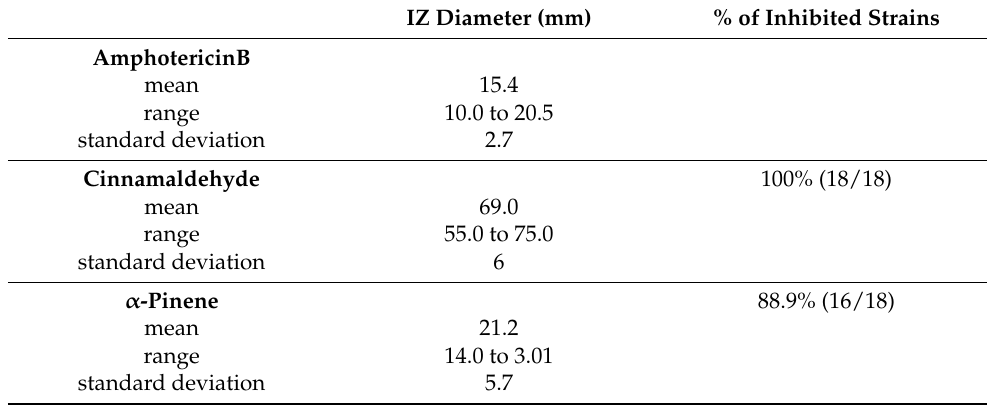
Table 1. Summary of antifungal activities of selected natural compounds against Candida